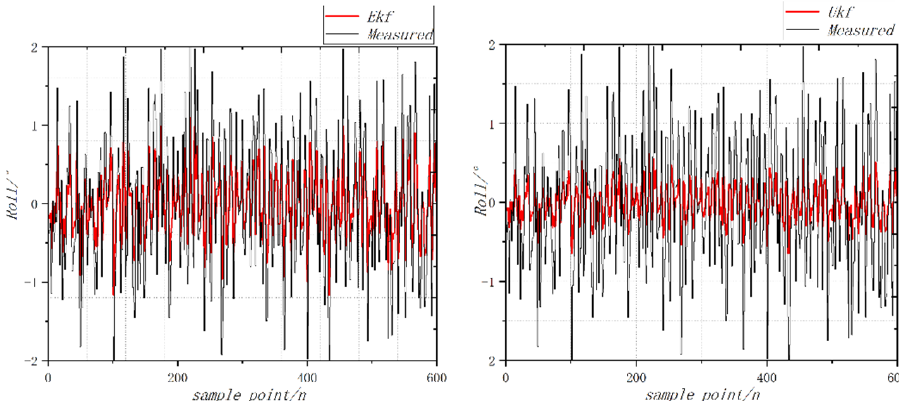
Figure 9. Curve of vibration acceleration of rolling motion.